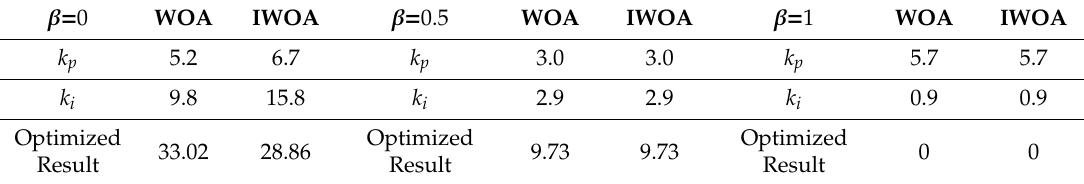
Table 6. Optimization results of WOA and